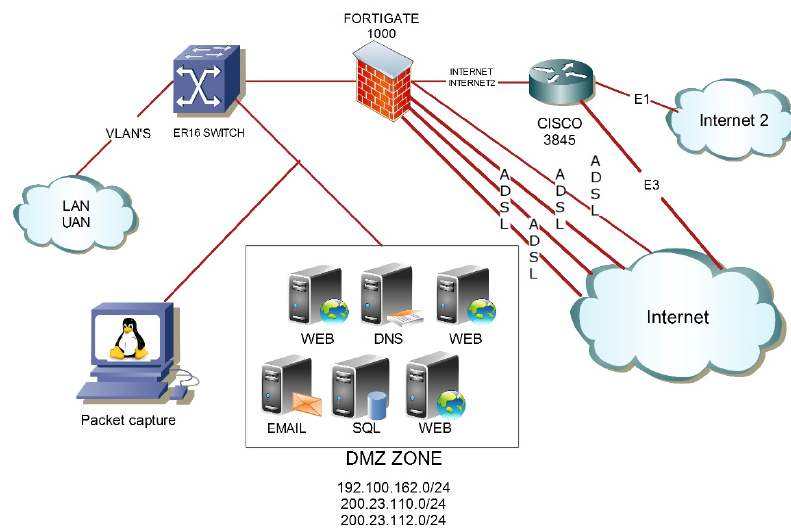
Figure 2. General diagram for the production